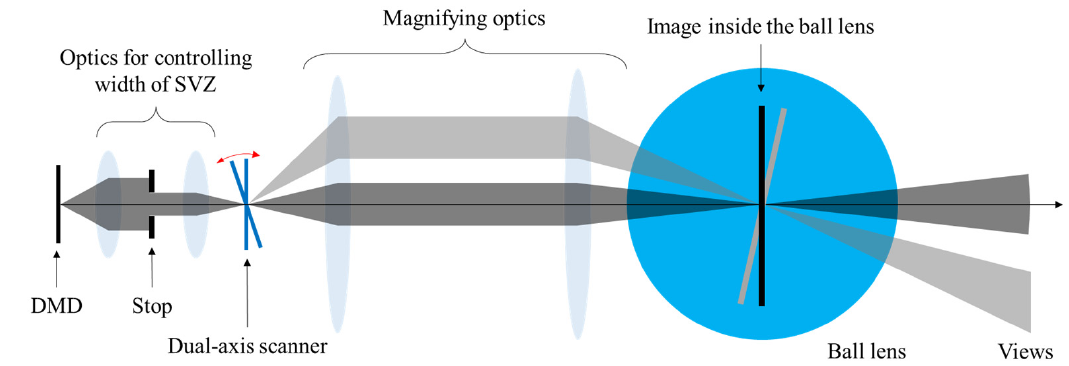
Figure 1. Schematic of the full-parallax multiview display with spherical symmetry.